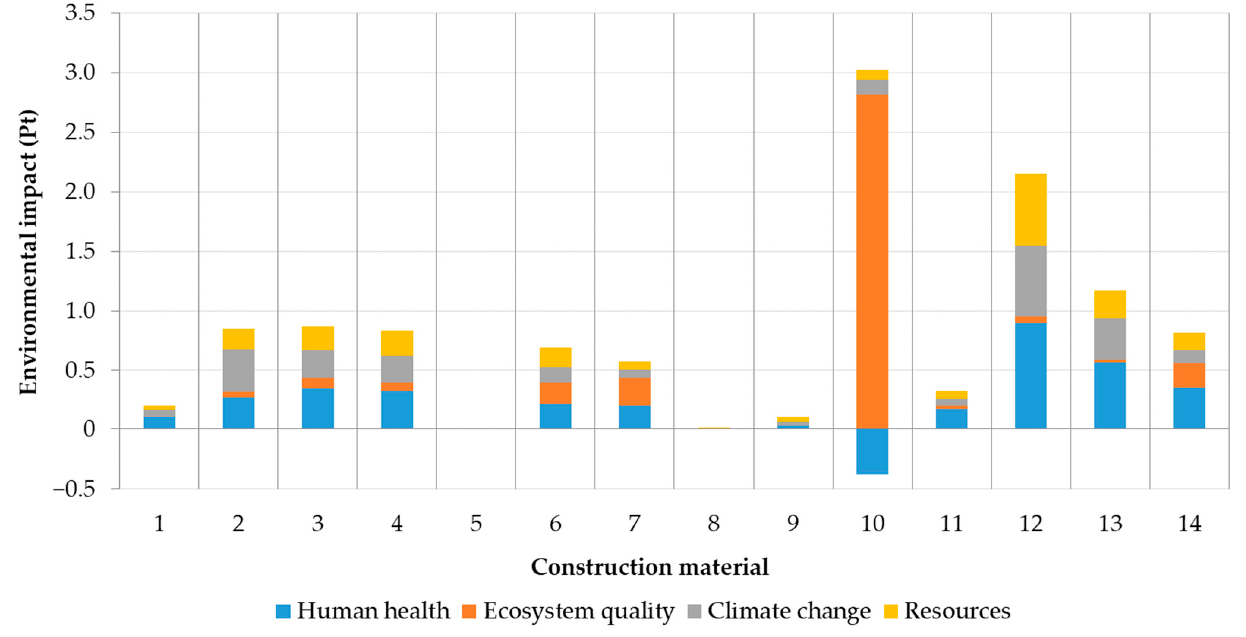
Figure 5. Contribution of each endpoint impact category (human health, ecosystem quality, climate change and resources) to the environmental impact of construction materials (Table 3)—a single score assessment. Numbers refer to construction materials listed in Table 3.